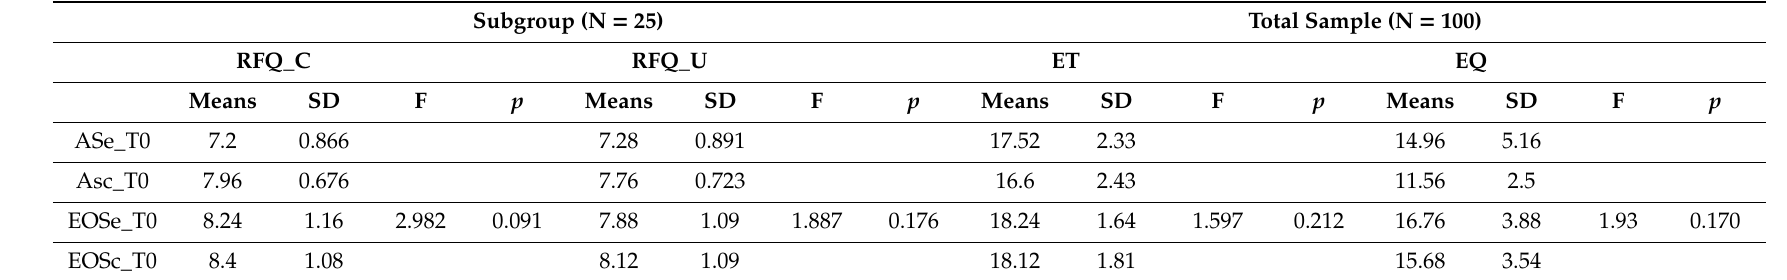
Table 2. Comparison between ASe / ASc and EOSe / EOSc at T0.